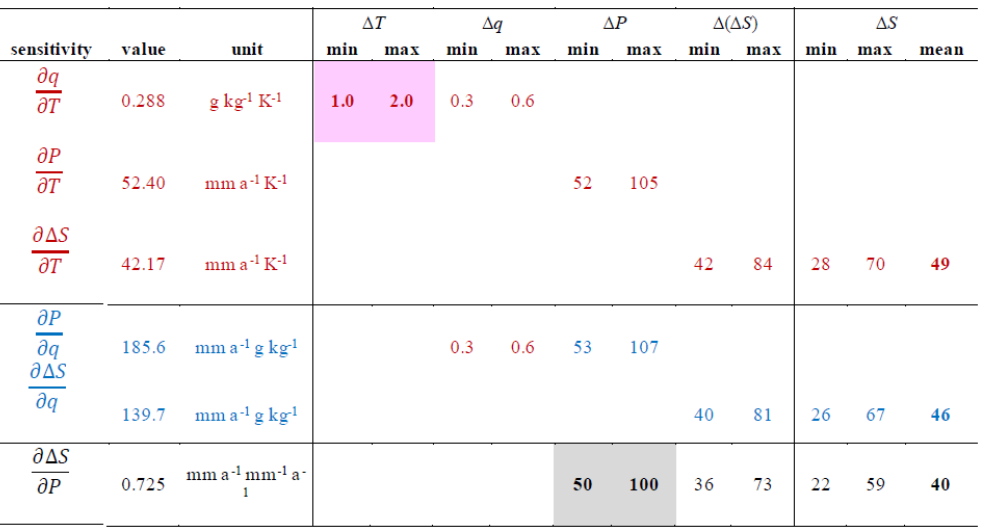
Table 2. Estimated changes in annual air temperature (cid:49)T (in ◦ C), specific humidity (cid:49)q (in gkg − 1 ), precipitation (cid:49)P (in mma − 1 ), and water balance (cid:49)((cid:49)S) (in mma − 1 ) in the Qaidam Basin (QB) with respect to present conditions and resulting estimated annual water balance (cid:49)S (in mma − 1 ) for the mid-Pliocene. Red colours: estimates based on changes (cid:49)T ; blue colours: estimates based on changes (cid:49)q ; black colours: estimates based on changes (cid:49)P . Input values for (cid:49)T (magenta shades) and (cid:49)P (grey shades) are estimates based on the studies of R. Zhang et al. (2013) and Mutz et al. (2018), while present values and sensitivities are derived from the HAR 10km data set during the hydrological years 2001 to 2014 as discussed in the